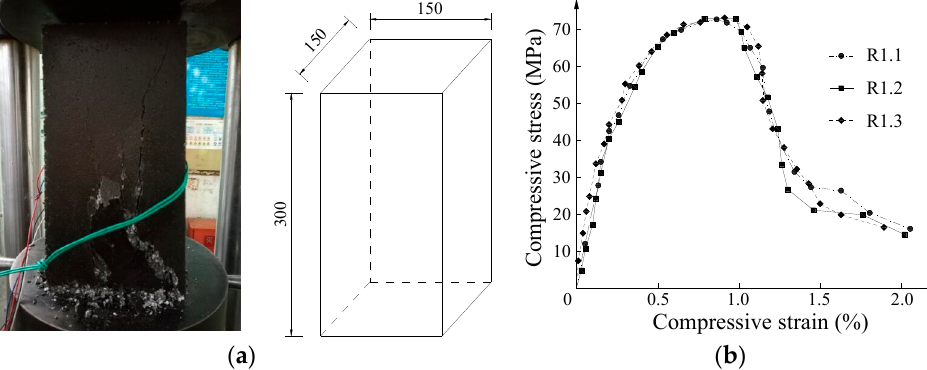
Figure 2. Compressive test of resin concrete: ( a ) Setup and prism specimen (mm), ( b ) stress-strain relationship.